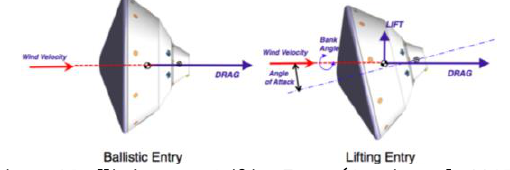
Figure 4.Ballistic versus Lifting Entry (Martin et al.,